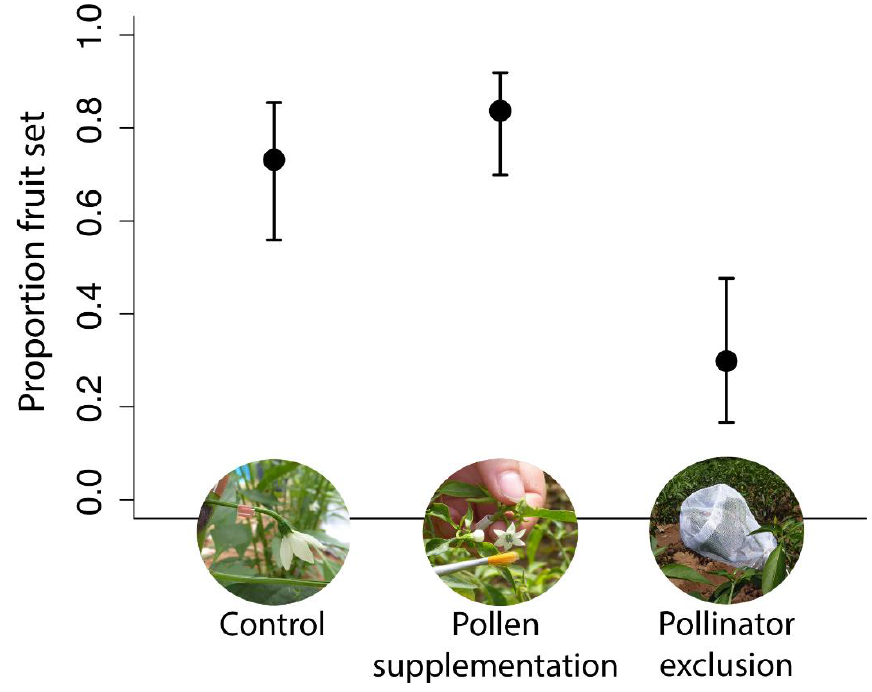
Figure 2. Fitted mean ± 95% CI of fruit set in the three treatments control, pollen supplementation (hand pollination), and pollinator